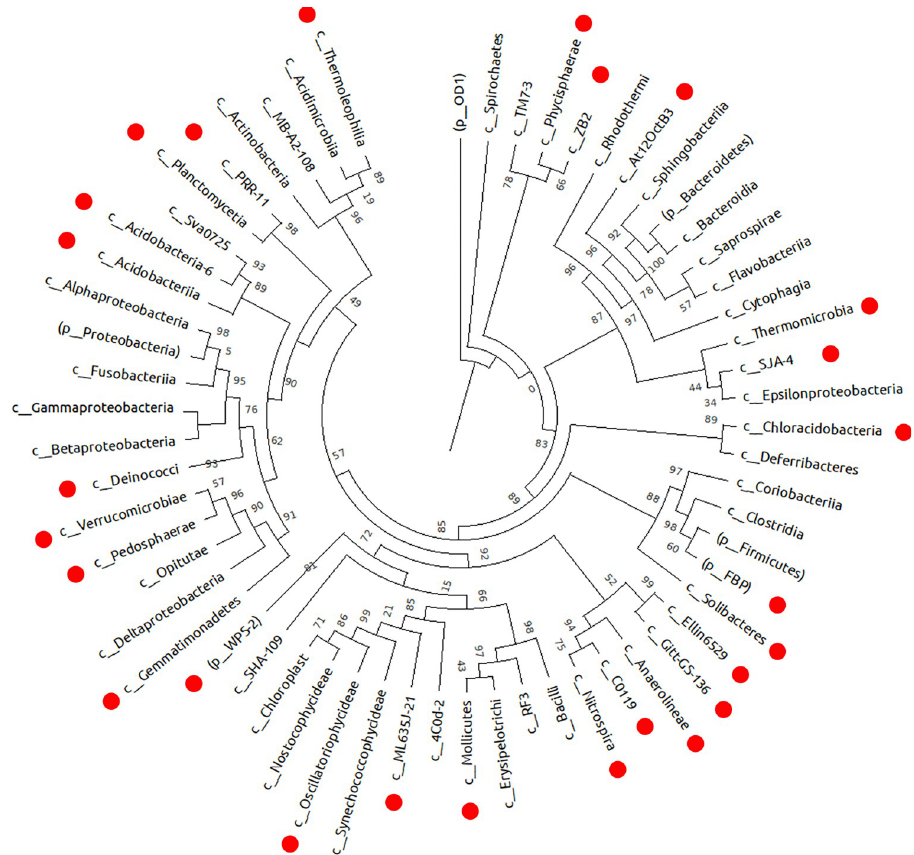
Fig 3. The phylogenetic tree of microbial communities at the class level. Red circles denote classes of bacteria that were found in the infected animals or in worm samples but not in the samples from uninfected animals.